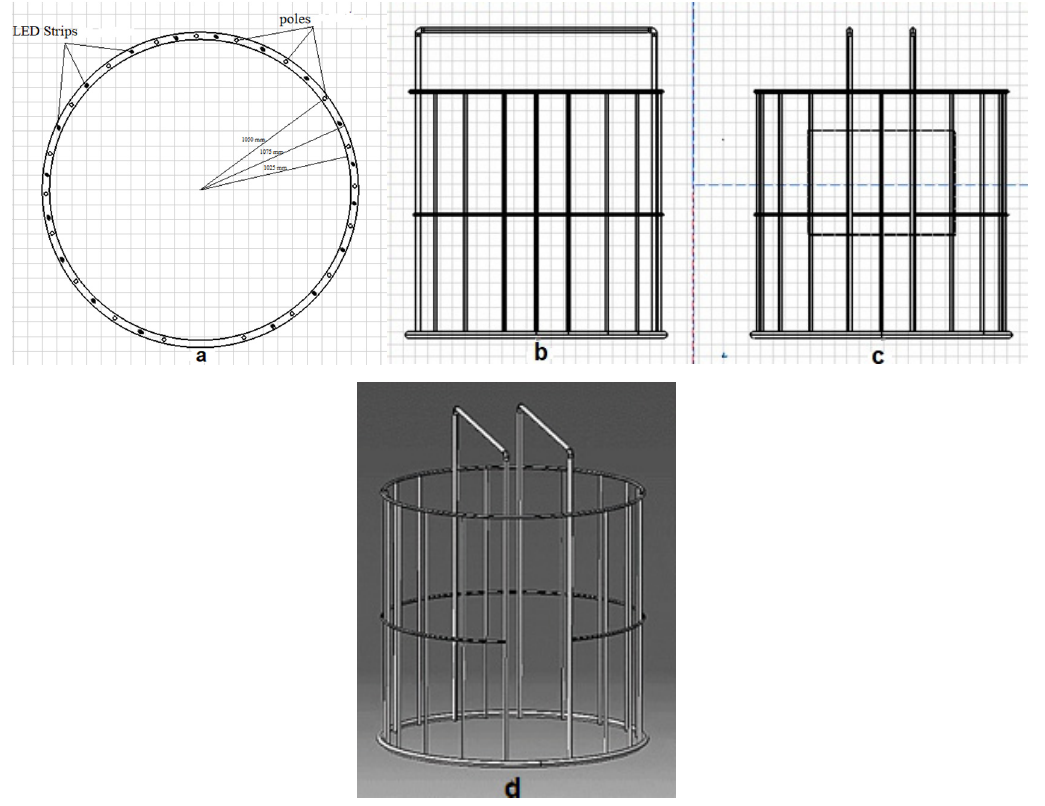
Figure 1. Physical structure of the scanner. ( a ) Top view: steel rods located at 105 cm from the center of the bottom circle. ( b ) Right view: 19 steel rods used for holding the controllers and cameras at specified distances. ( c ) Front view: the angle of the poles on the bottom ring are different from each other. This angle is 15° for the front and sides views of the subject and 20° for the other poles. ( d ) Perspective view of the physical structure.